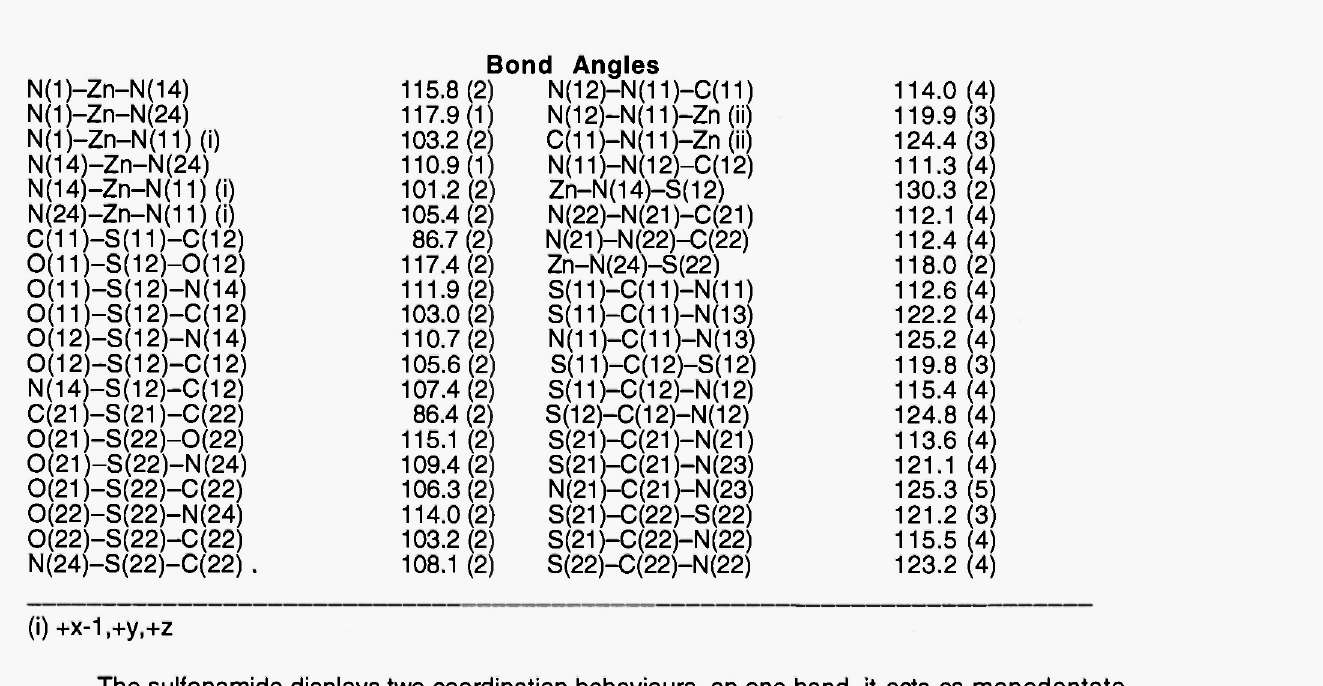
Table IV. Hydrogen Contacts (Ä, °) for the [Zn(5-amino-1,3,4-thiadiazole-2- sulfonamidate) 2 (NH 3 )].H 2 0. X-H...Y X-H X...Y H...Y <X-H...Y 0(1 )-H(01)...0(21) 0.44 2.95(1) 2.54 161 N(1)-H(0103)...0(1) (i) 0.85 2.67 152 N(13)-H(1301 )...N(22) (ii) 0.96 N(1)-H(0101)...N(21) (iii) 0.97 3.13(1) 2.26 148 N(1)-H(0102)...0(22) (iv) 0.99 3.07 (1) 2.08 173 N(13)-H(1302)...0(22) (v) 0.92 2.91 (1) 2.00 167 N(14)-H(14)...0(1)